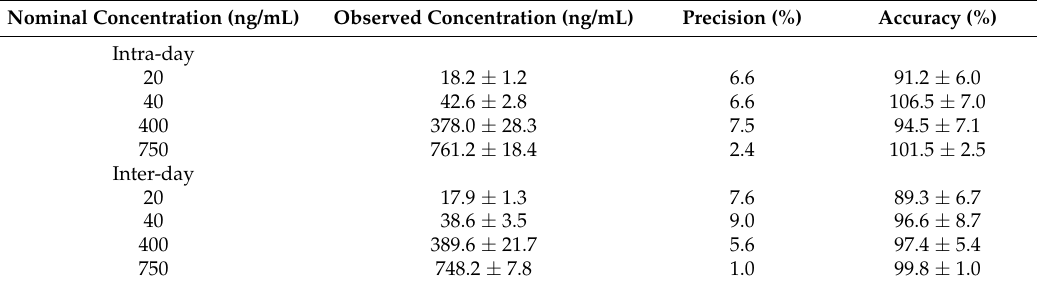
Table 1. Accuracy and precision of QC samples for FTS analysis.